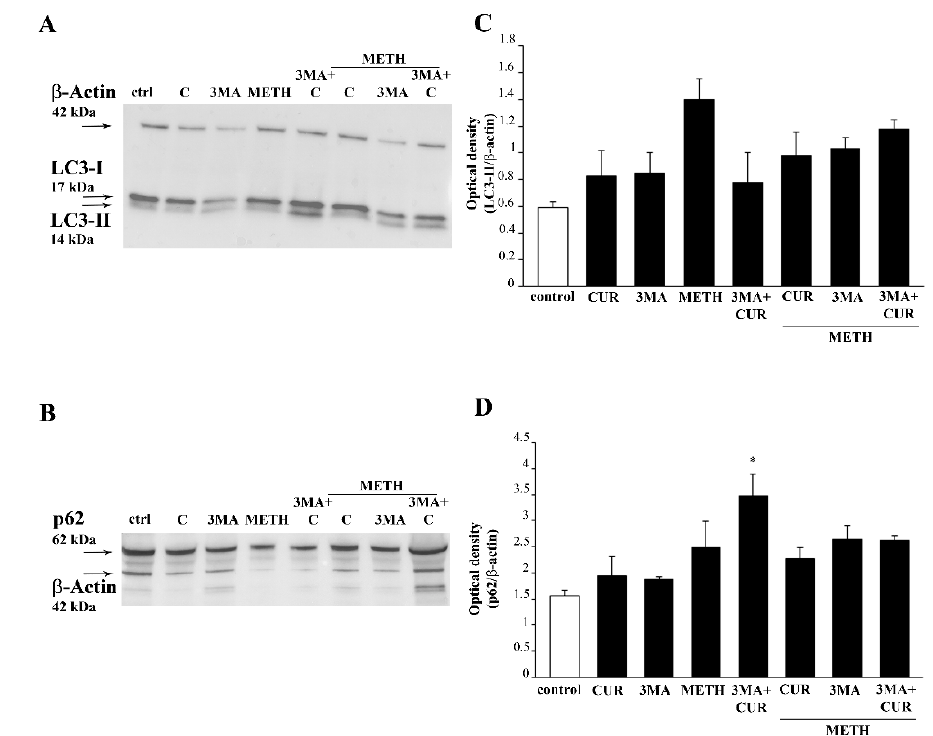
Figure 20. CUR induces autophagy in METH-treated cells. Immunoblotting for LC3-I and LC3-II ( A ) and p62 ( B ) and the graphs reporting the related optical densities ( C and D , respectively). * p ≤ 0.05 compared with control.